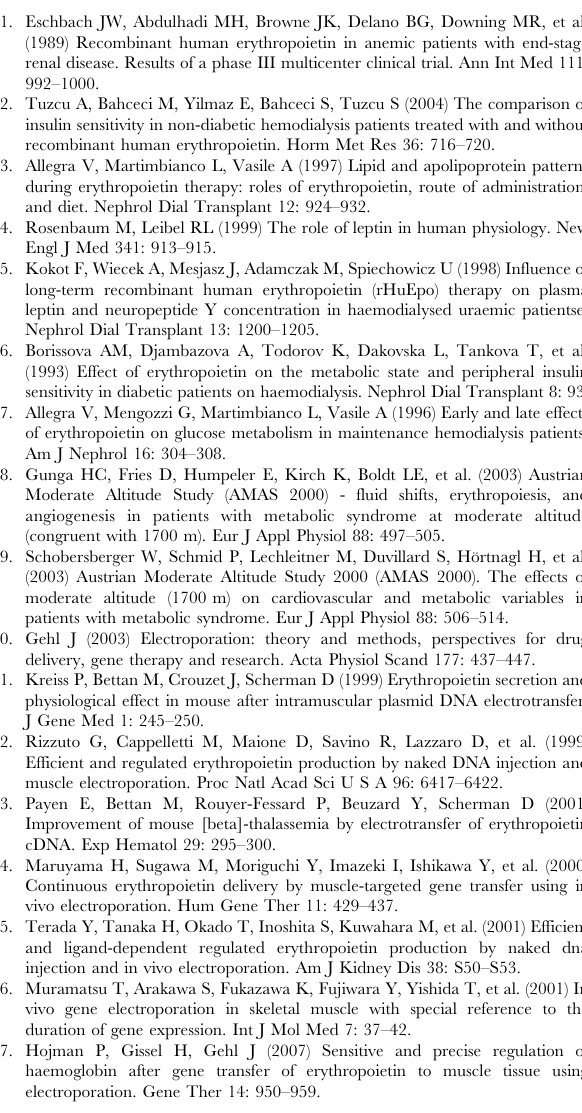
Bonferroni corrections for multiple testing, and there were no significant difference between the groups. Figure S3 The improvement in glucose tolerance is reversed when EPO expression is withdrawn. Fourteen weeks after doxycycline withdrawal in EPO transfected mice, a glucose tolerance test was performed. There was no difference in the glucose tolerance between the control and EPO transfected high- fat fed mice. Found at: doi:10.1371/journal.pone.0005894.s003 (1.49 MB